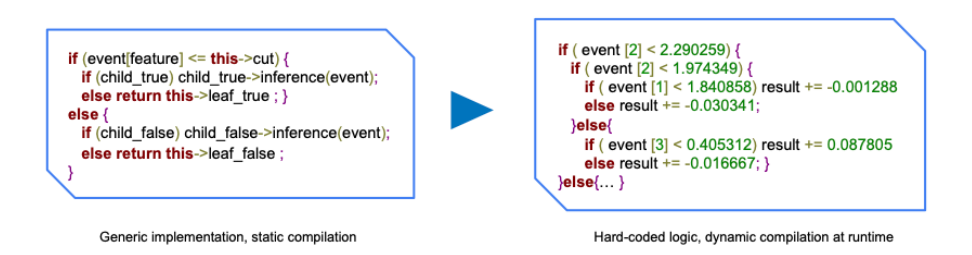
Fig. 1. Code snippet demonstrating the use of just-in-time compilation for the TMVA fast inference engine for decision-tree based algorithm. Conventional generic implementation is presented on the left, and the code snippet generated and compiled at runtime after reading the model file and parsing the tree is presented on the right.